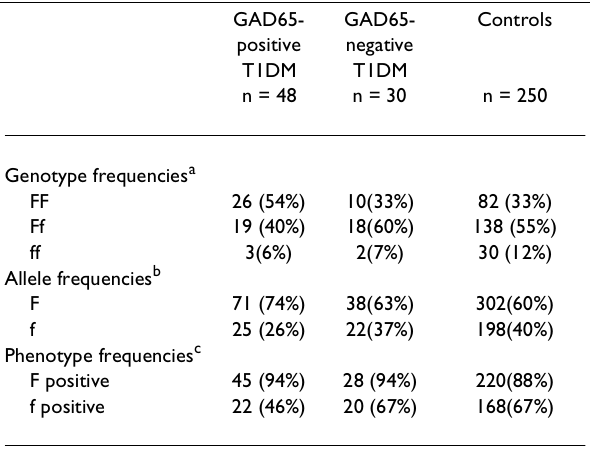
Table 2: VDR- Fok I polymorphism in study subjects analyzed with respect to GAD65 antibody status